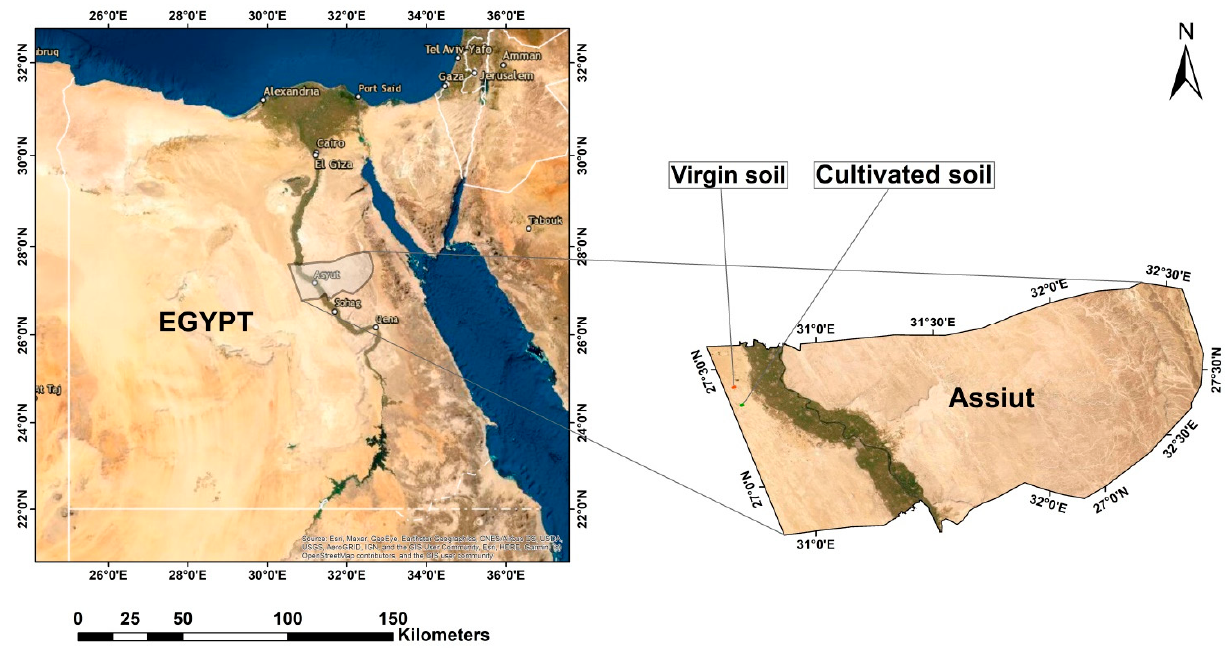
Figure 1. The location of the study area in relation to the maps of Assiut Governorate ( on the right ) and Egypt ( on the left ).